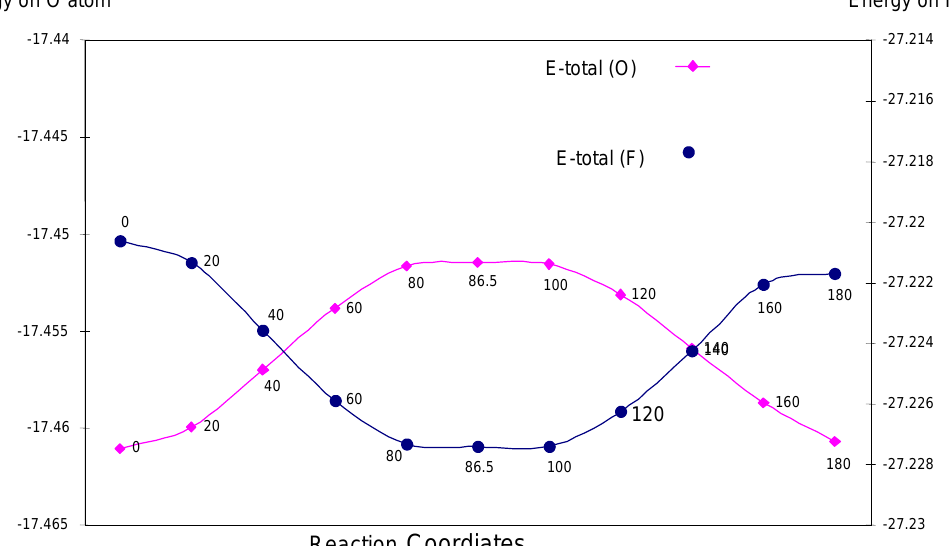
Figure 12. Plot of the one-center energies (a.u) on 'O' and 'F' atom centers as a function of torsional angles in fluorine